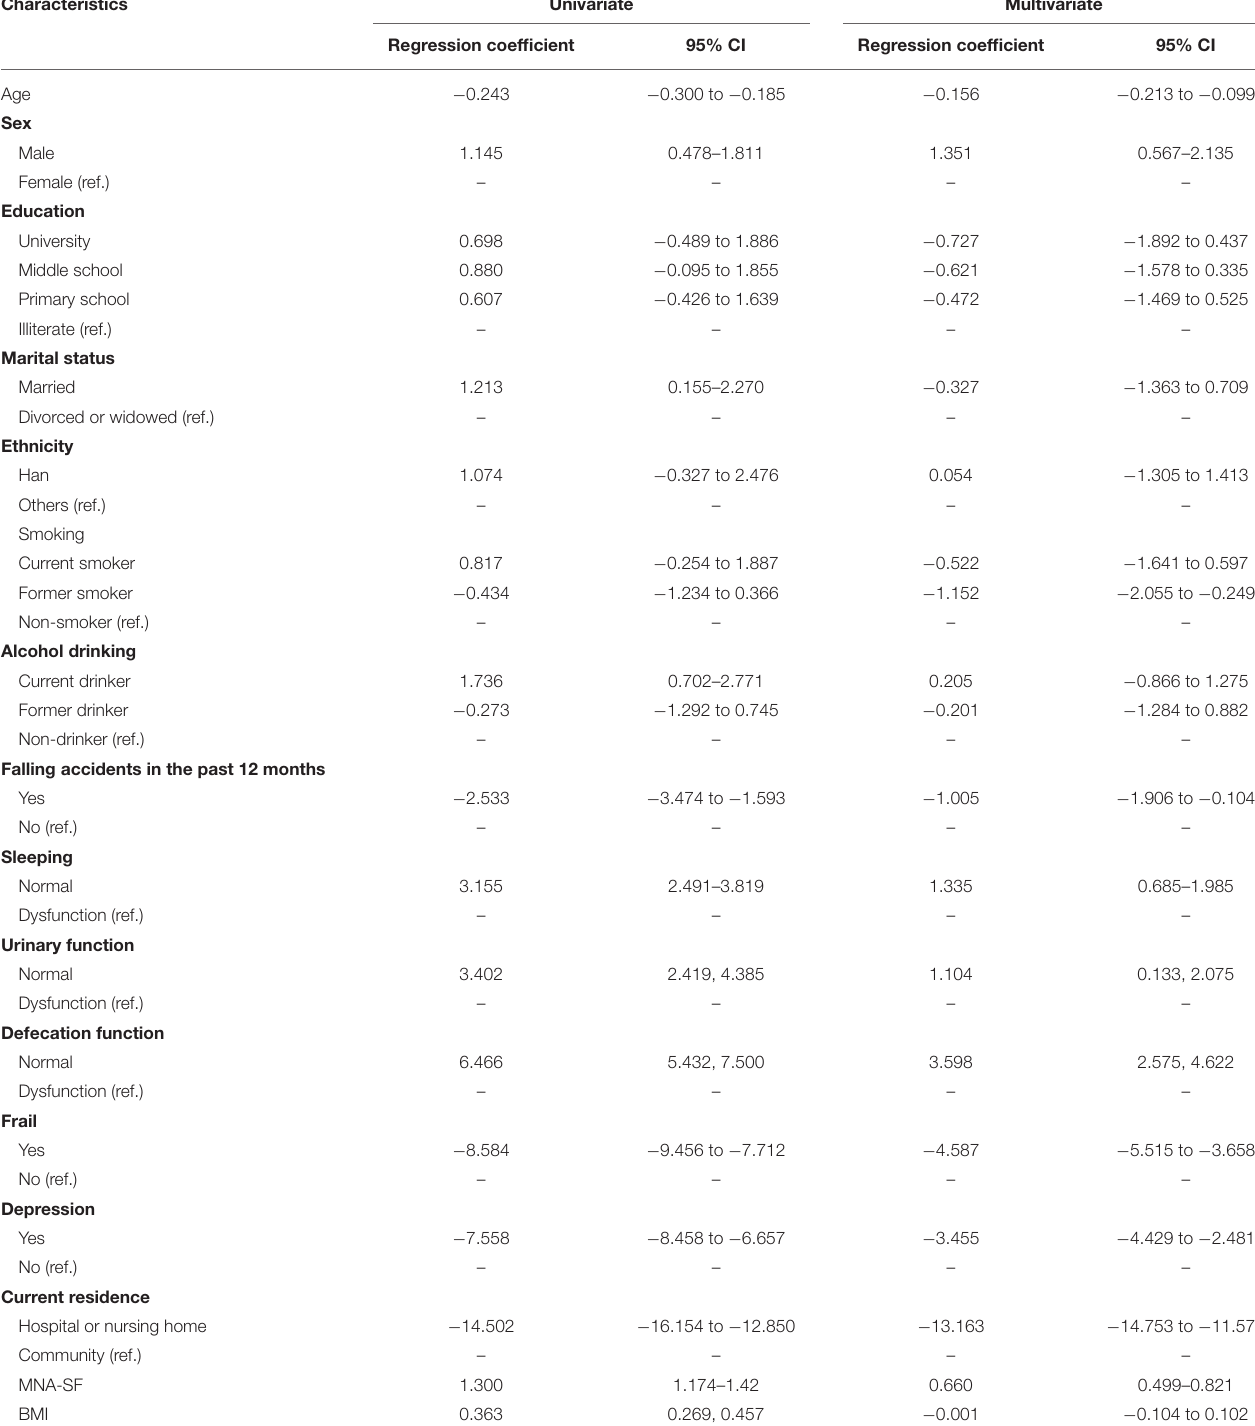
TABLE 4 | Variables that can affect the EQ5DVAS score from the regression model (30-day follow-up).